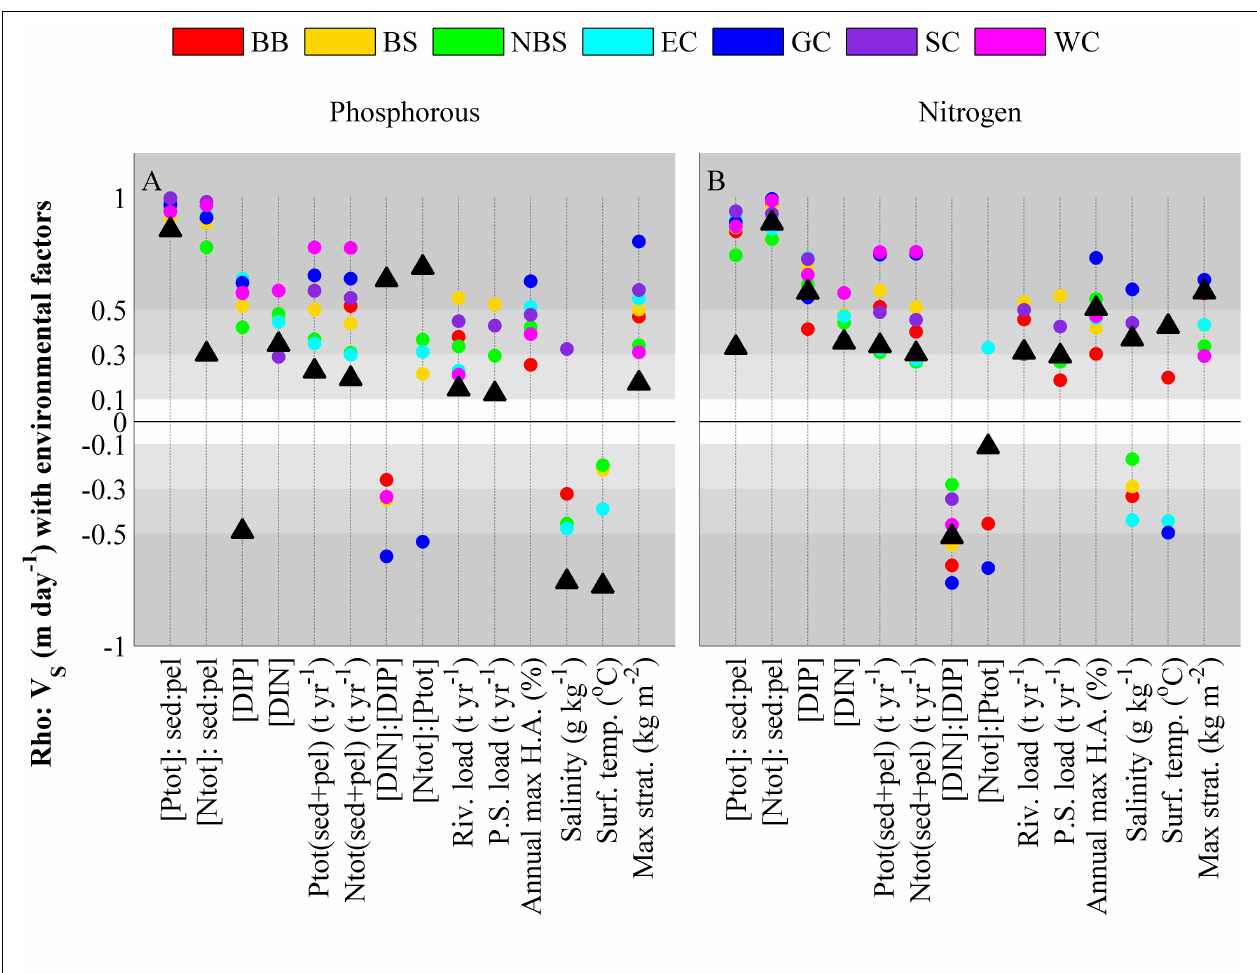
FIGURE 10 | Spearmans rank correlation coefficients for the 20 years averaged V S for phosphorous (A) and nitrogen (B) tested against environmental factors. All environmental factors are taken as 20-year averages from the model set-up, input or output. Concentrations are denoted with brackets and are expressed in mmol m − 3 for the water mass and mmol m − 2 for the sediment. DIN and DIP represents winter values (November–January). In the labels, hypoxic area has been abbreviated with H.A and point sources with P.S. Colored dots shows correlations within one of the MRs and black triangles denote the correlation of all water bodies along the Swedish coast. Insignificant correlations ( p > 0.05) are not